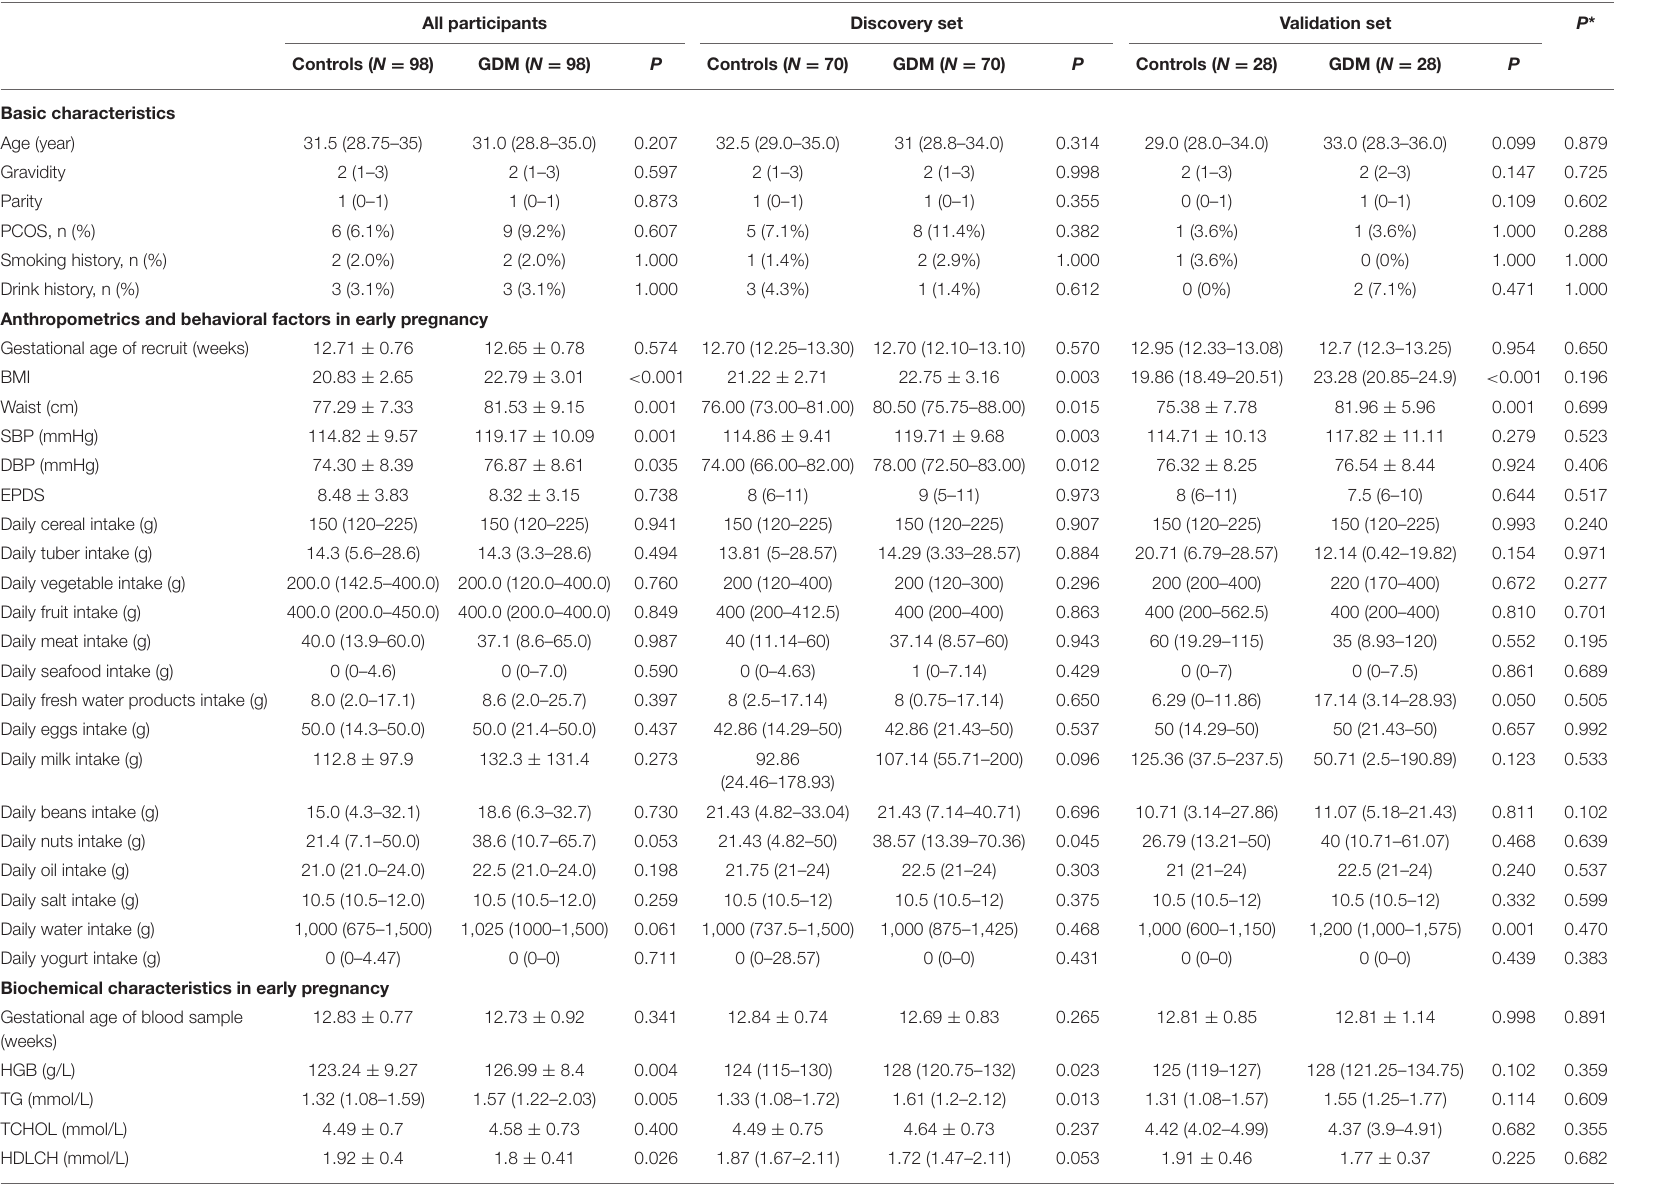
TABLE 1 | Characteristics of the study population #